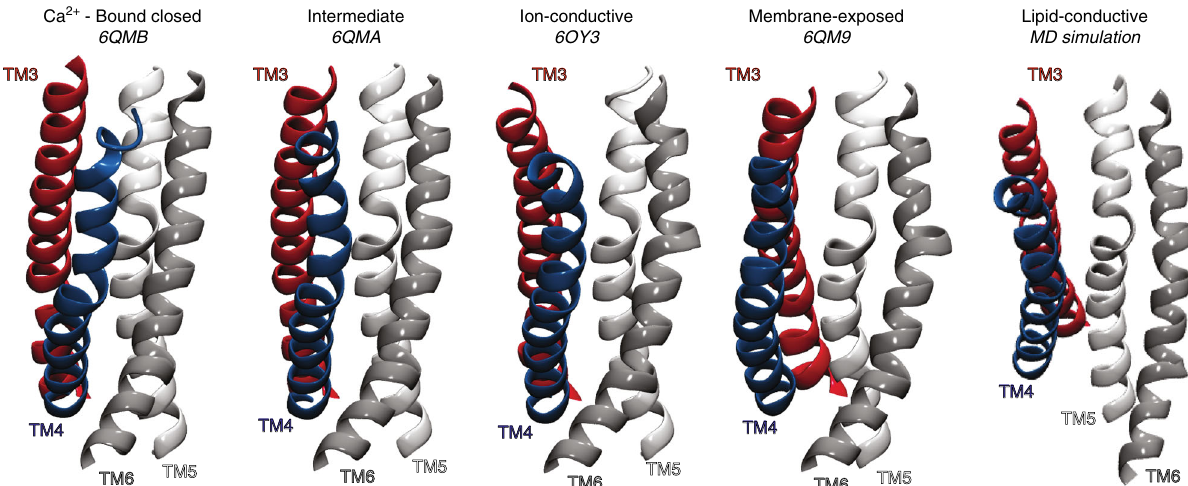
Fig. 10 Structural and functional characteristics of the known conformations of the groove of Ca 2 + -bound nhTMEM16 scramblase. The groove conformations shown are (from left to right): Ca 2 + -bound closed (PDBID 6QMB 18 ); intermediate (PDBID 6QMA 18 ); ion-conductive (PDBID 6OY3, this study); membrane-exposed (PDBID 6QM9 18 ); and lipid-conductive (obtained from MD simulations 21 ). In all structures, TMs 3 – 6 are colored in red, blue, white, and silver, respectively, and are